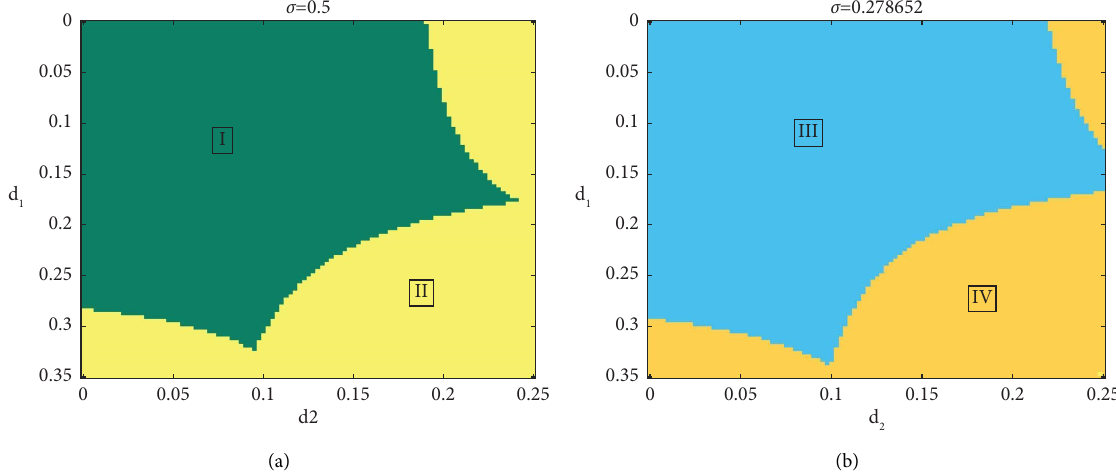
and d , we choose R � 2 , k � 1 , c � 0 . 8 , σ ∗ � 0 . 278655, and σ ∗ < σ � 0 . 5 < 1 1 2